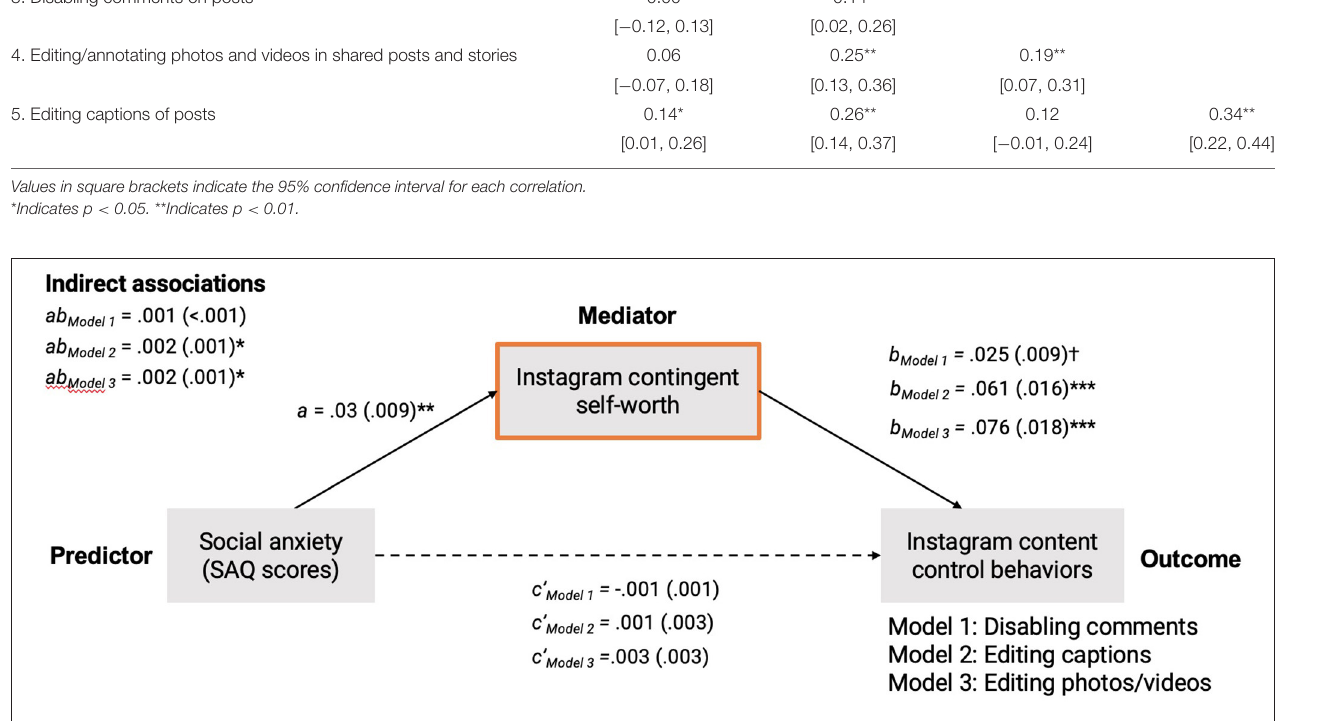
FIGURE 1 | Path diagram depicting all direct and indirect paths represented by the three mediation models predicting Instagram content control behaviors as a function of social anxiety levels and Instagram contingent self-worth. Estimates of indirect associations are designated by ab . Dashed lines indicate direct paths between the predictor and the outcome measures. Potential influences of age, sex, and daily Instagram screen time (not shown) are controlled for in all paths. All numbers indicate unstandardized path coefficients, with estimates of standard error in parentheses. † Indicates p < 0.10; *indicates p < 0.05; **indicates p < 0.01; *** indicates p < 0.001. P -values for indirect associations are